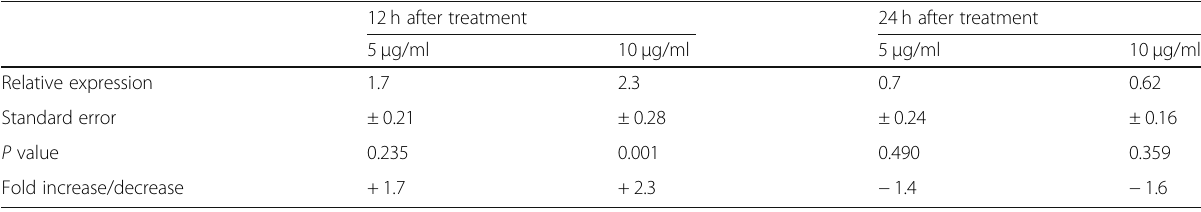
Table 3 The total expression ratio of the gene of TGF β 1 in the MEFs treated with various concentrations of ethanol extract of Calendula (5 and 10 μ g/ml) relative to control group is presented in each time (12 and 24 h after treatment). The statistic test for significance is randomization re-allocation test, implemented in the relative expression software tool. Significant down or upregulations of the genes highlighted